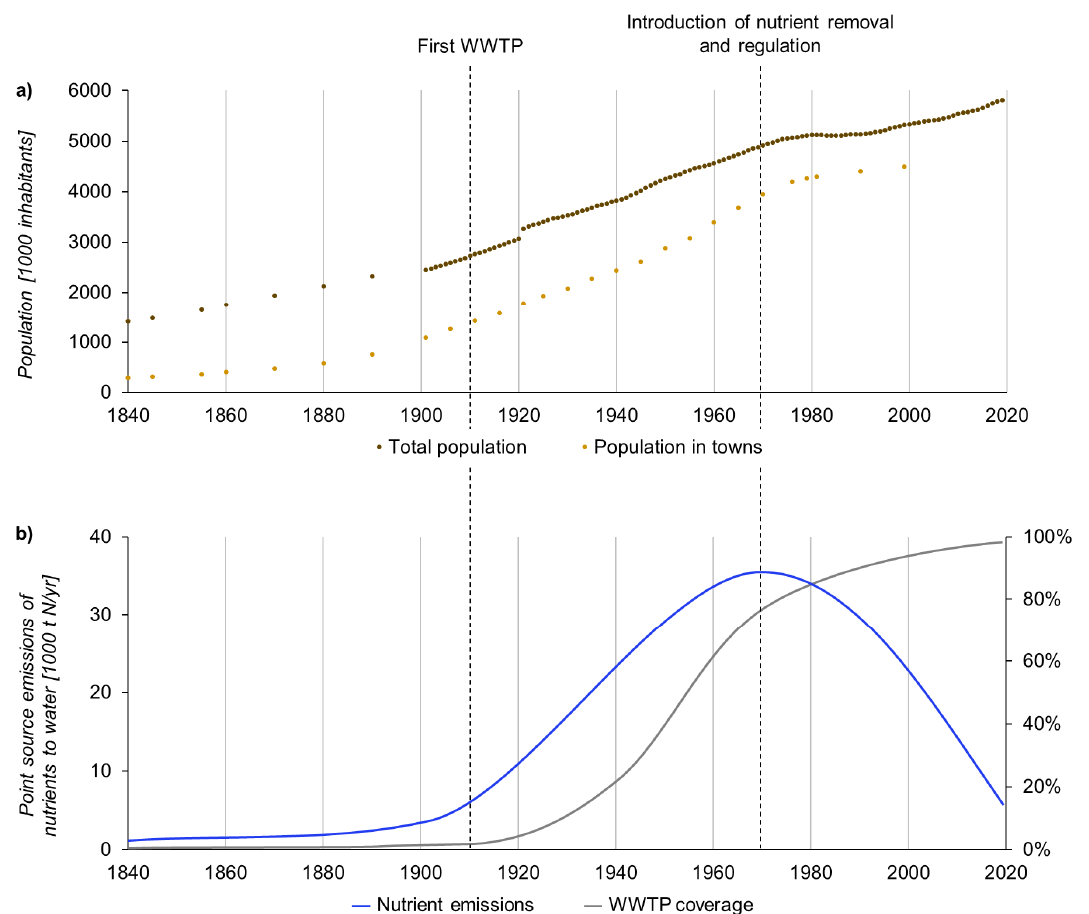
Figure 1. Historical development from 1840 until today of ( a ) the Danish total population and town population, based on [8–10]; ( b ) estimated development of nutrient emissions to receiving water and fraction of households and industry connected to wastewater treatment plants (WWTP), based on [11,12]. Milestones are marked with vertical lines and based on [11–13].